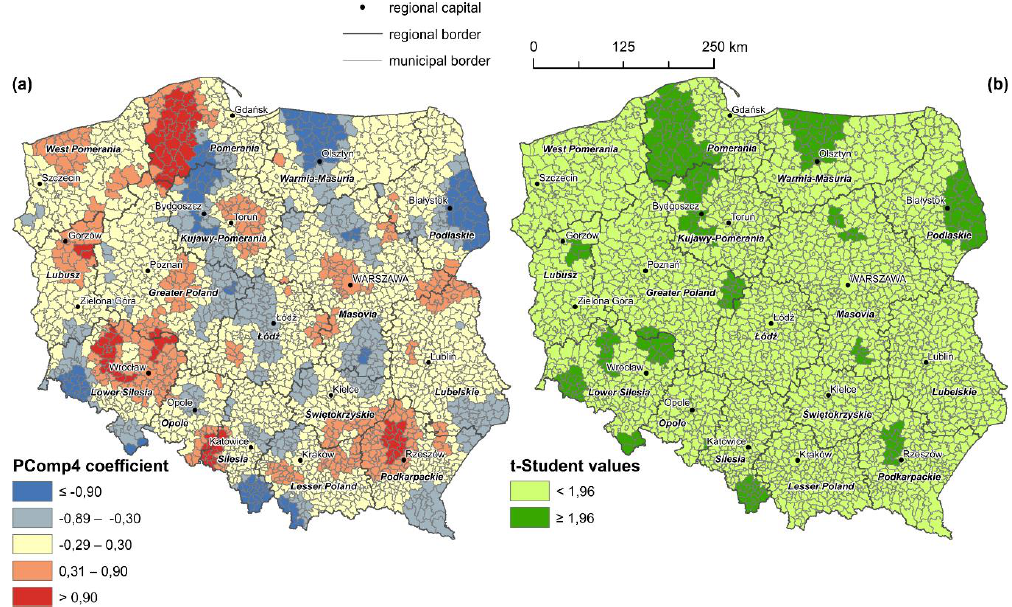
Figure 8. Value ( a ) and significance ( b ) of impact of the fourth component “inaccessibility” on land cover changes in Poland, in the years 2012–2018.